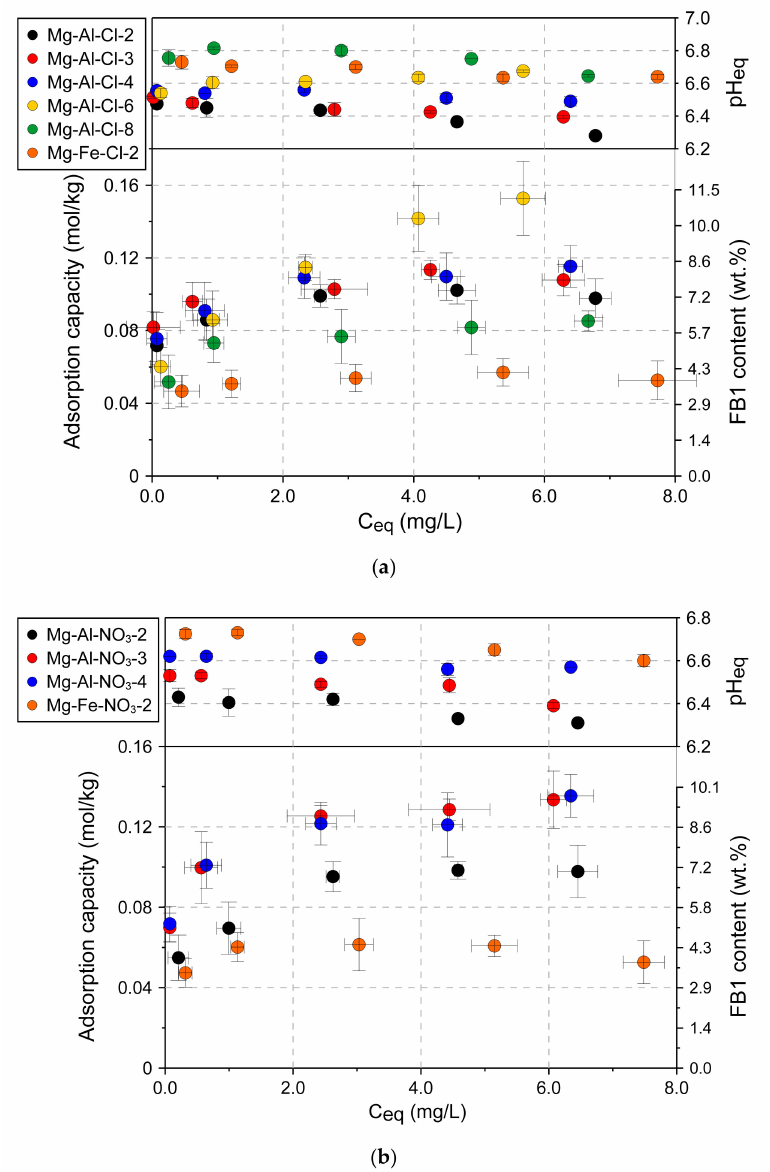
Figure 6. Adsorption isotherms for LDH materials: ( a ) Cl intercalated samples and ( b ) NO 3 intercalated